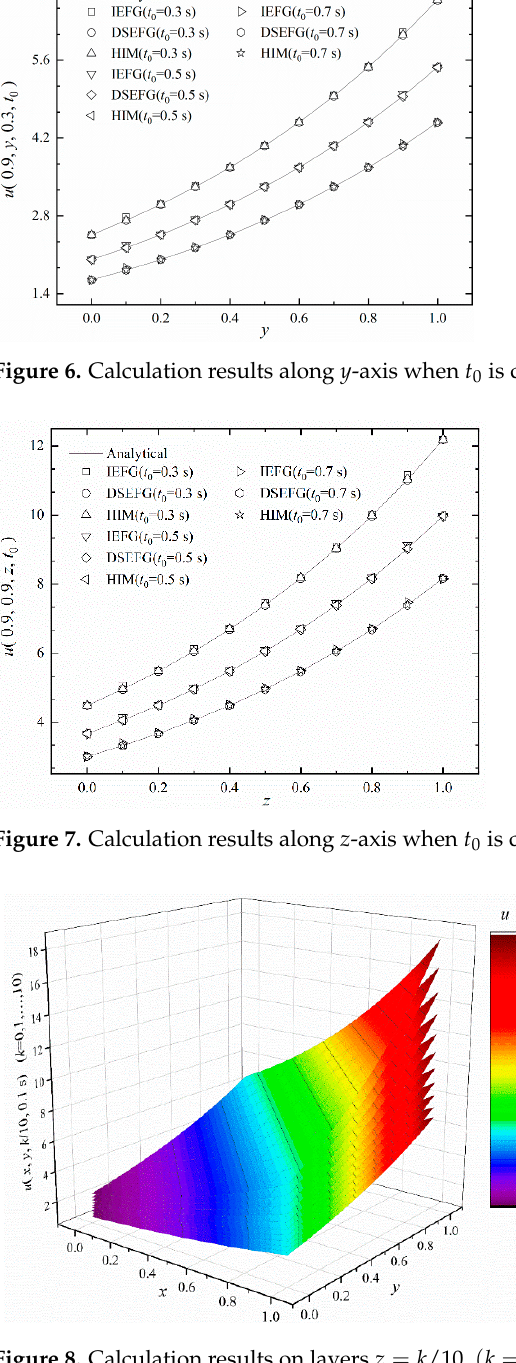
is different. is different. 0 0